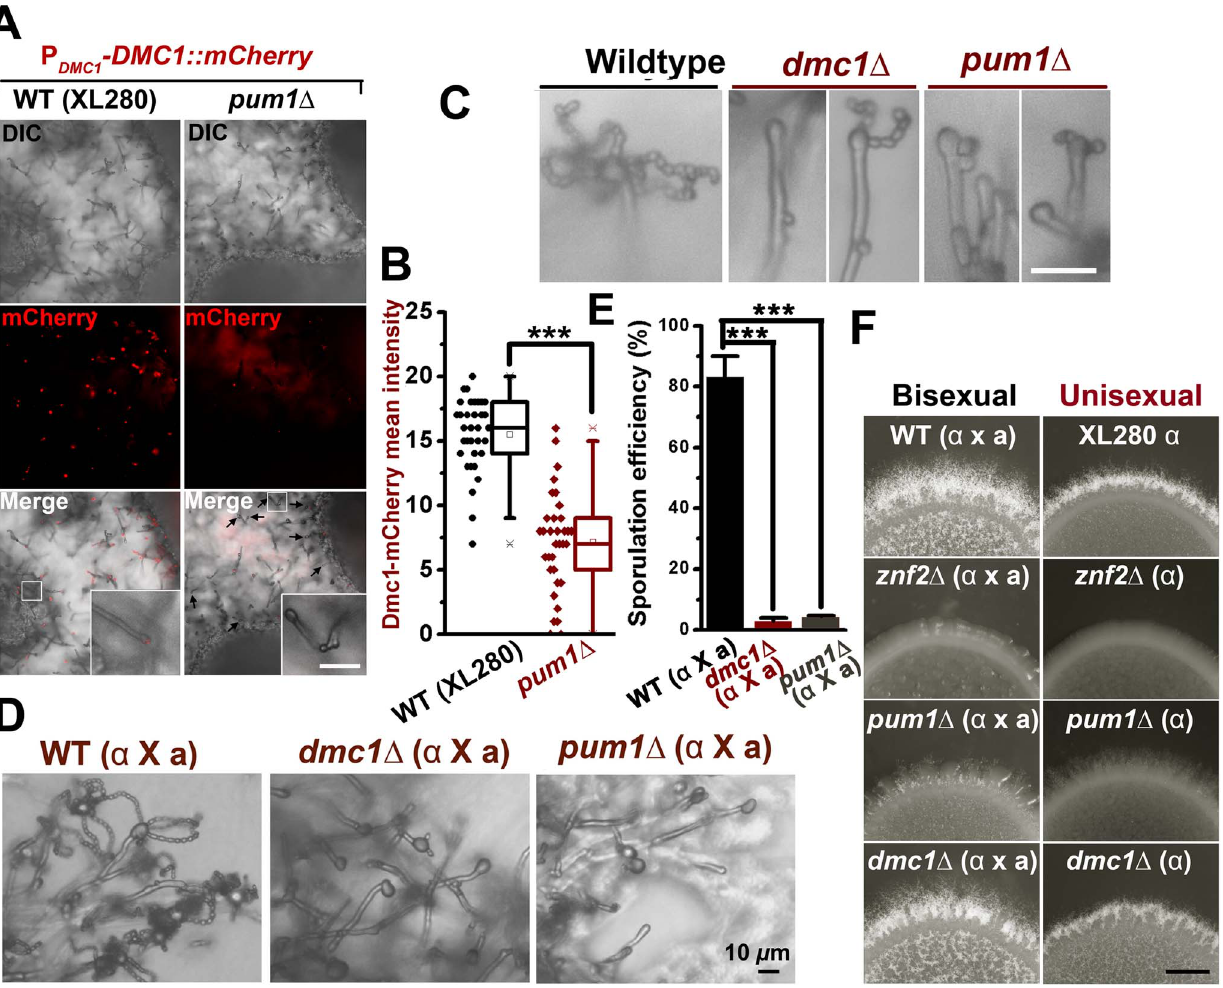
Figure 7. Pum1 coordinates filamentation and sexual reproduction. (A and B) The deletion of PUM1 impairs the expression of Dmc1 in basidia in a stochastic manner. Some but not all differentiating basidial heads lost the expression of Dmc1-mCherry without Pum1. Those that did expressed Dmc1at lower levels. Scale bars: 20 m m. (C) The unisexual sporulation was perturbed in the absence of the meiosis-specific protein Dmc1 and the global regulator Pum1. The wildtype strain XL280, the dmc1 D mutant, and the pum1 D mutant were diluted on V8 agar to form single colonies. Typical mature basidia observed from these strains were shown. Scale bar: 10 m m. (D and E) The deletion of PUM1 and DMC1 also dramatically reduced the sporulation efficiency during bisexual mating. (F) The effect of the deletion of ZNF2 , PUM1 , or DMC1 on aerial hyphal morphogenesis at the colony level during both bisexual and unisexual development. Scale bar: 1 mm.